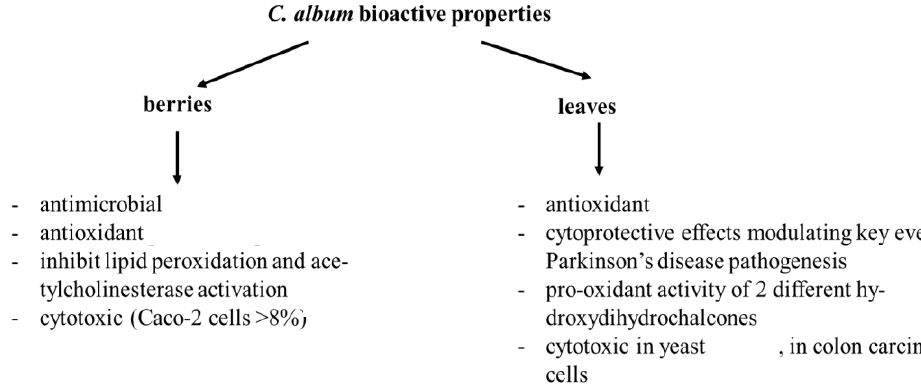
Figure 2. Structure of identified chalcones in C. album : ( A ) R = OH, 2′ , 4′ -dihydroxydihydrochalcone, R = OCH 3 , 2′ -methoxy- 4′ -hydroxydihydrochalcone; ( B ) 2′ , 4′ -dihydroxychalcone.